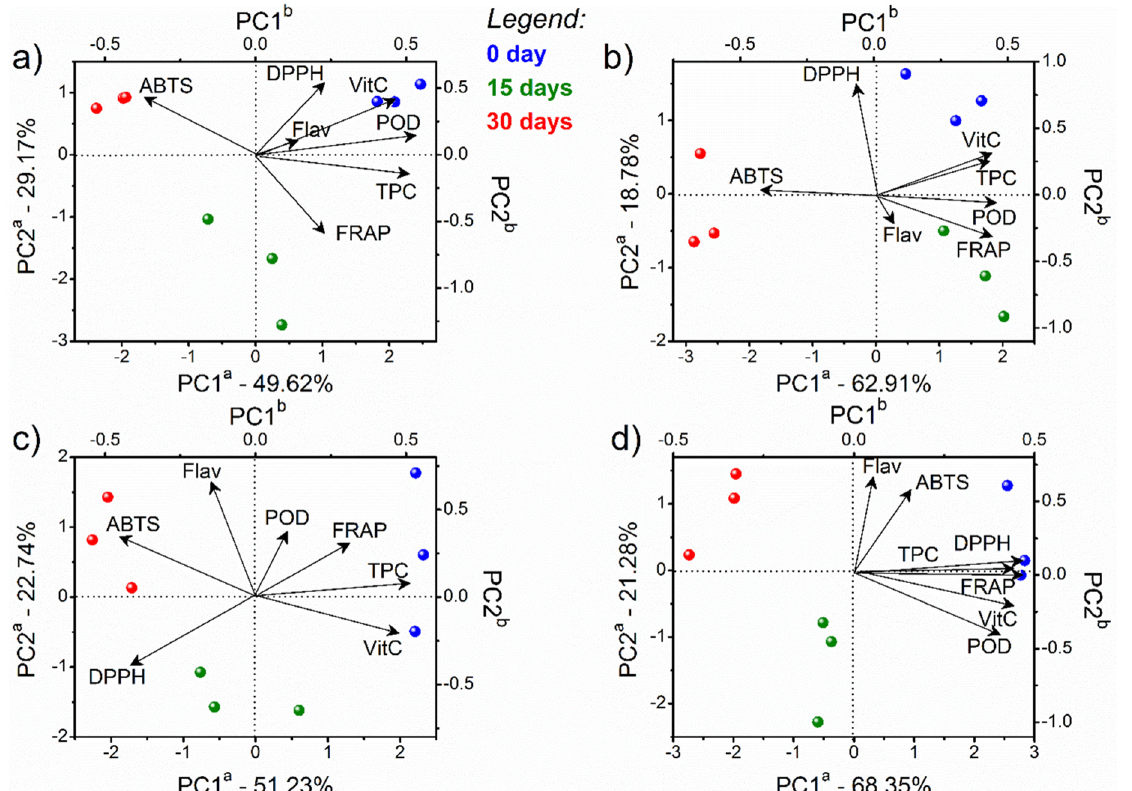
Figure 4. PCA biplot (scores and loadings) of the stability of cashew apple juices: ( a ) control (non-processed); ( b ) after thermal processing by PAST; ( c ) after sequential processing by OZ (Oz3) followed by US (US8), and ( d ) US (US8) followed by OZ (Oz3). The juices’ stability was analyzed after 0 (blue), 15 (green), and 30 days (red). The letter a in the PC axes refers to scores axes, and b refers to loadings axes with variables represented by vectors from the origin.